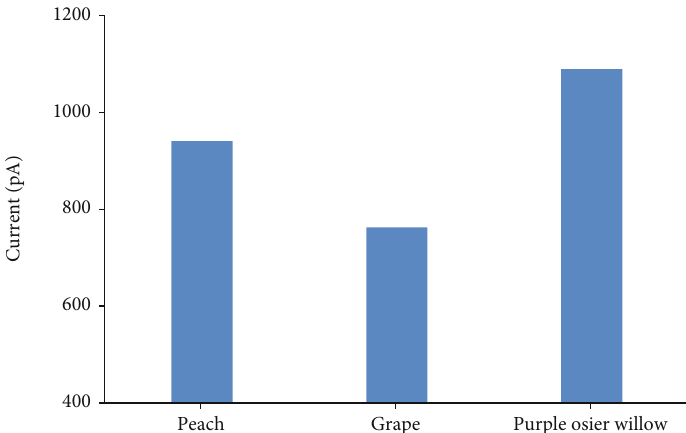
Figure 7: Current intensity comparison of SKOR channel homologs from peach, grape, and purple osier willow. The electrophysiological function of peach PpSKOR, grape VviSKOR [30], and purple osier willow SpuSKOR [9] was veri fi ed by patch clamping system. The current signal was recorded when the K + concentration was set at 0mmol · L -1 and the voltage was set at 100mV. Data are shown as the means recorded from 5 independent